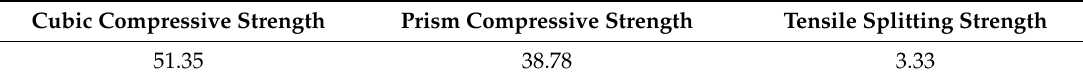
Table 3. Material properties of NSC (MPa).